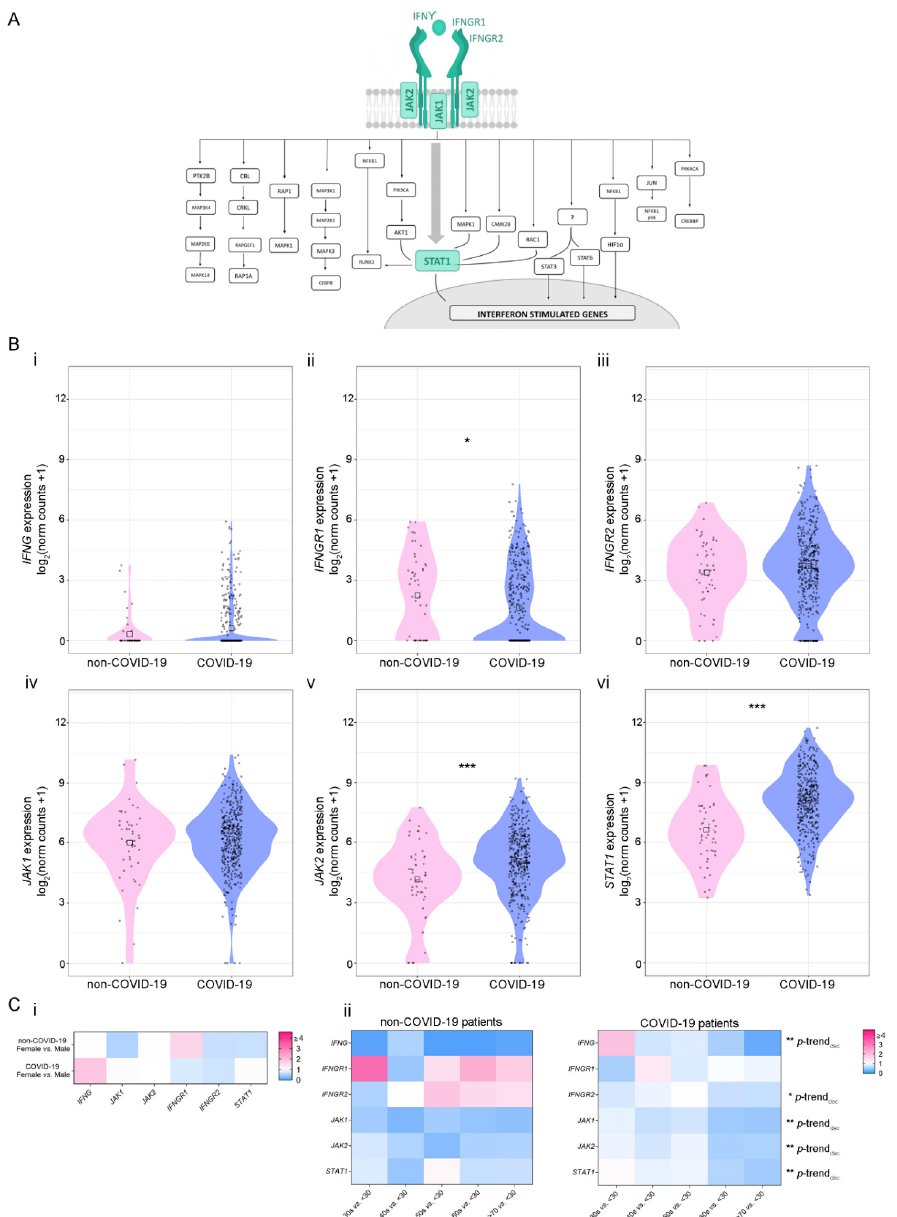
Figure 2. Expression of genes belonging to the canonical IFN- γ pathway in non-COVID-19 and COVID-19 patients. ( A ) Schematic representation of IFN- γ signaling pathway associated genes. The canonical IFN- γ pathway is represented in green. ( B ) Gene expression analysis (log2 (norm counts +1)) for (i) IFNG , (ii) IFNGR1 , (iii) IFNGR2 , (iv) JAK1 , (v) JAK2 , and (vi) STAT1 in COVID-19 (purple) vs. non-COVID-19 (pink) patients from the GSE152075 dataset, assessed by RNA-seq. p -values correspond to Wilcoxon rank-sum test. Black squares represent the median. ( C ) Heatmaps depicting the fold change (high = pink; low = blue) for gene expression of genes belonging to the canonical IFN- γ pathway considering sex (i) and age groups 30 s, 40 s, 50 s, 60 s, and 70 s vs. <30 (ii) in non-COVID-19 (left panel) and COVID-19 (right panel) patients from the GSE152075 dataset, assessed by RNA-seq. p -values correspond to decreasing Jonckheere–Terpstra trend test. Statistical significance * p < 0.05; ** p < 0.01; *** p <